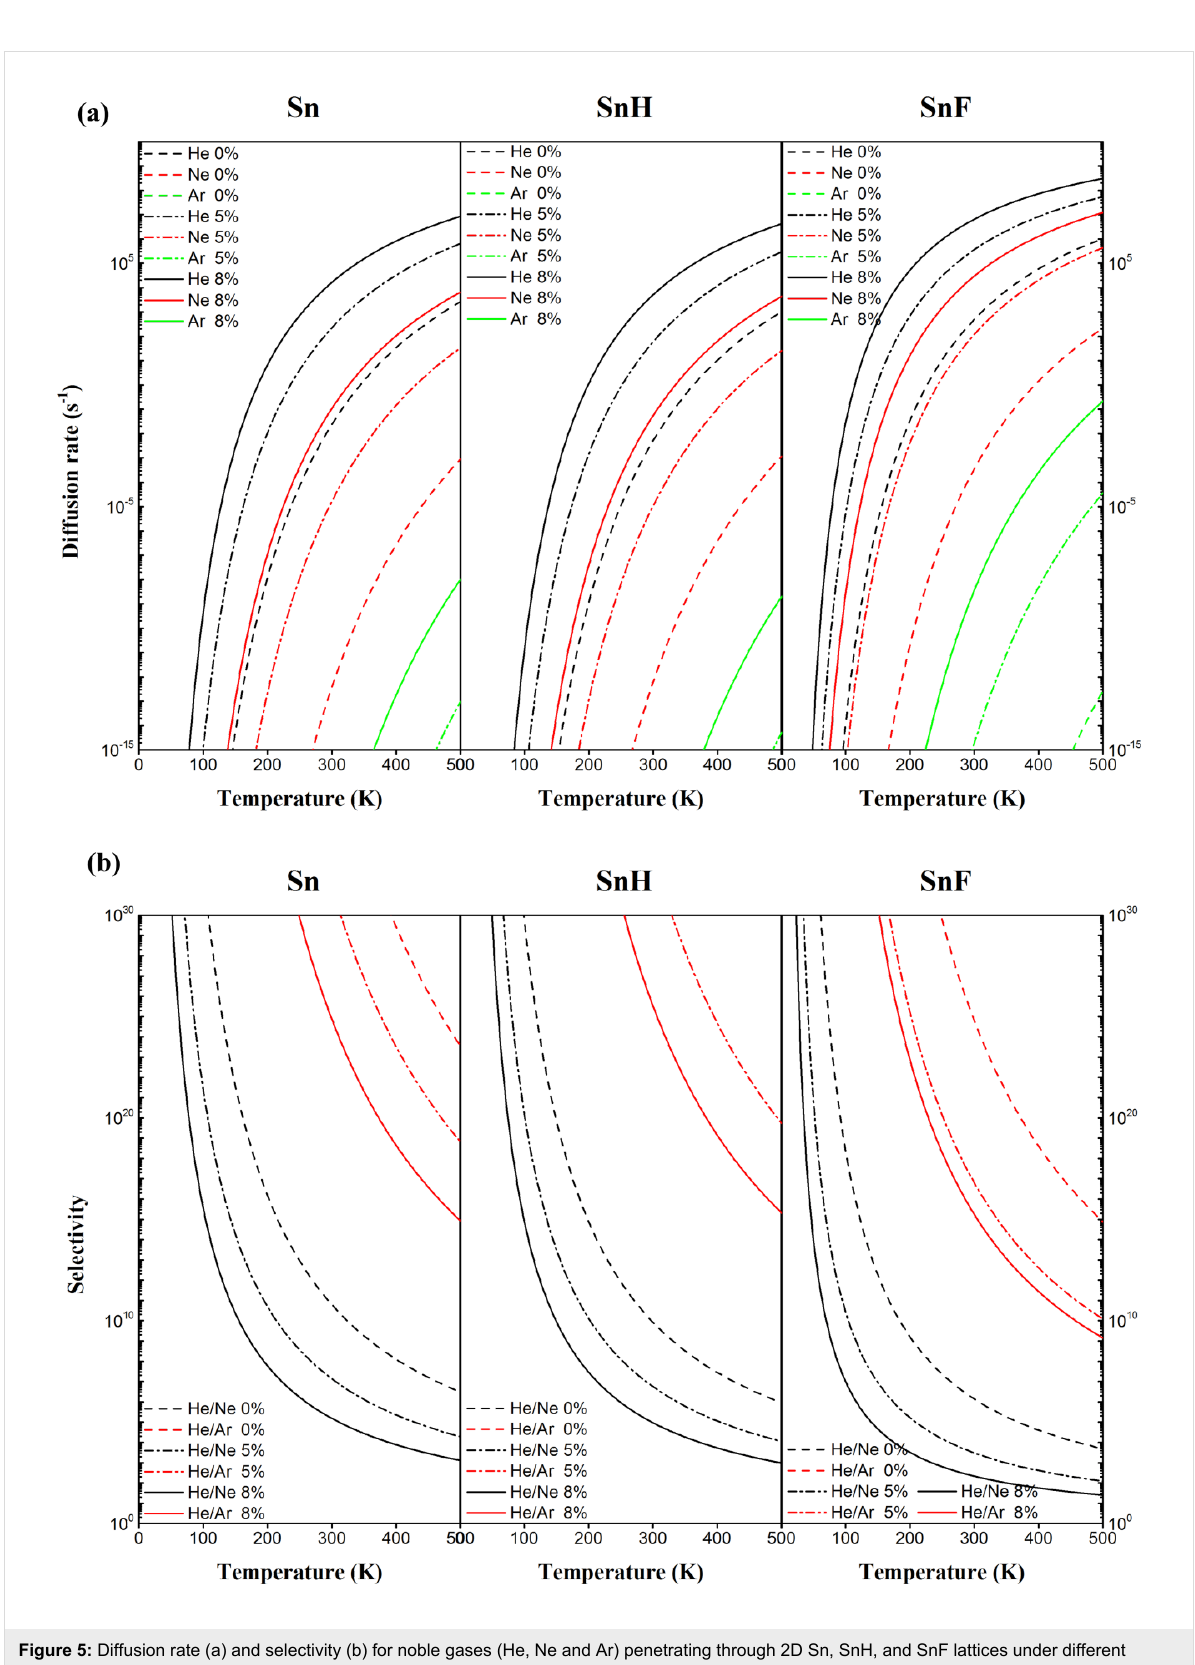
Figure 5: Diffusion rate (a) and selectivity (b) for noble gases (He, Ne and Ar) penetrating through 2D Sn, SnH, and SnF lattices under different